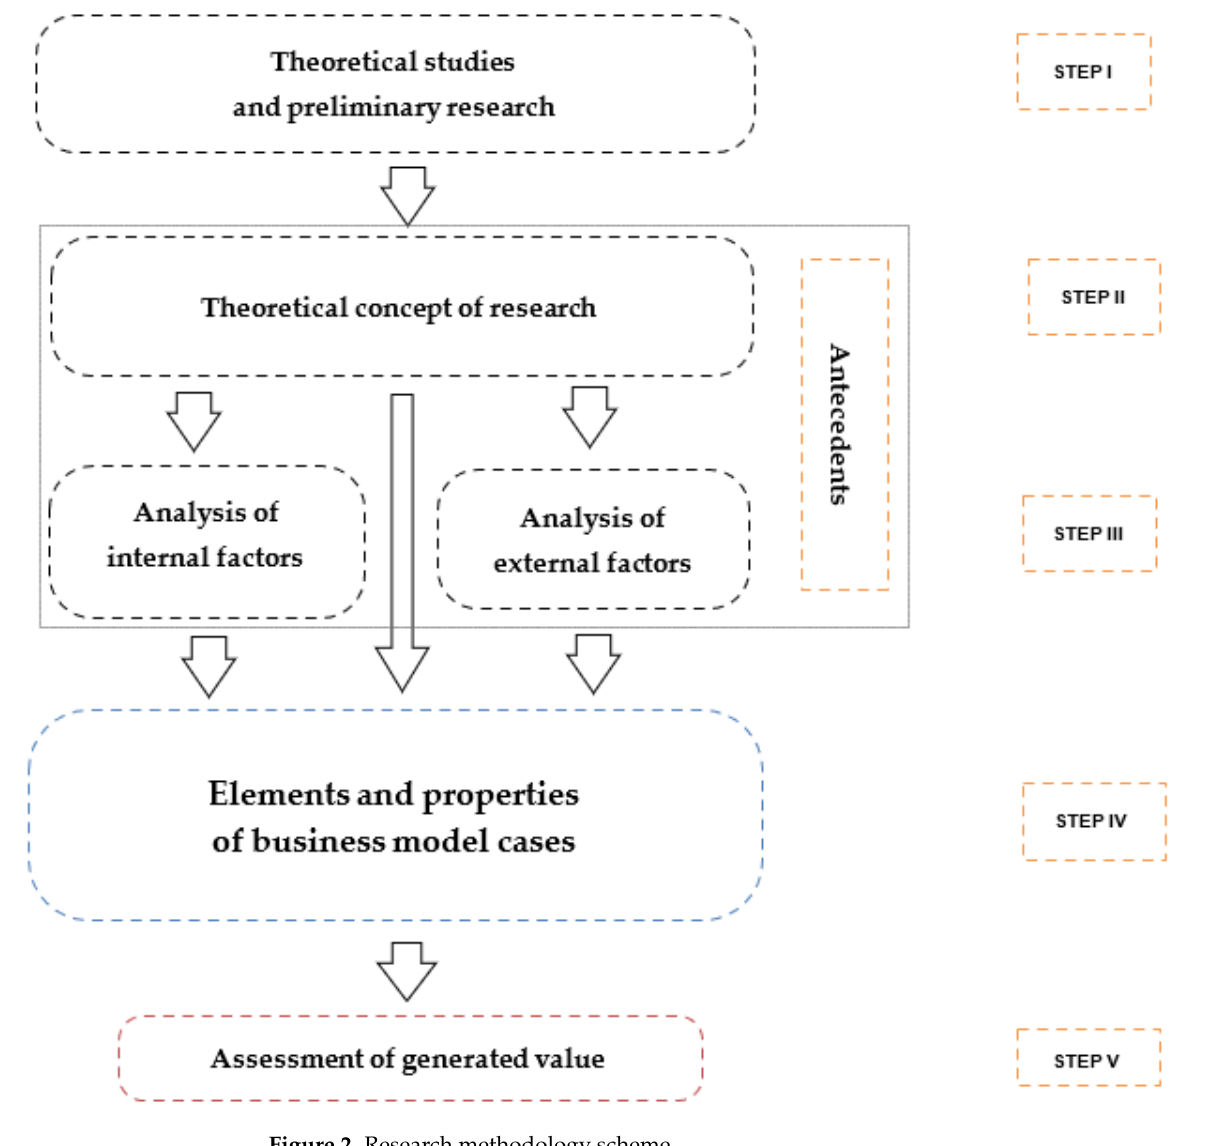
Figure 2. Research methodology scheme.